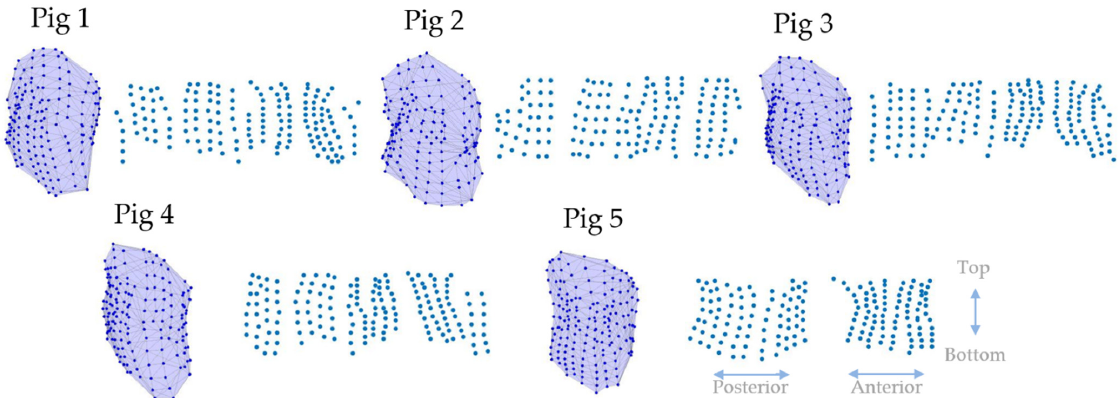
Figure 4. Results of torso node registration to the 2D plane. The 3D view shows the original 3D distribution of the torso nodes, where the ECGs were recorded. The 2D scatter plot shows the distribution of the nodes after projection to a cylinder. The double arrow indicates regions that belong to the anterior, posterior, top, or bottom areas of the torso.